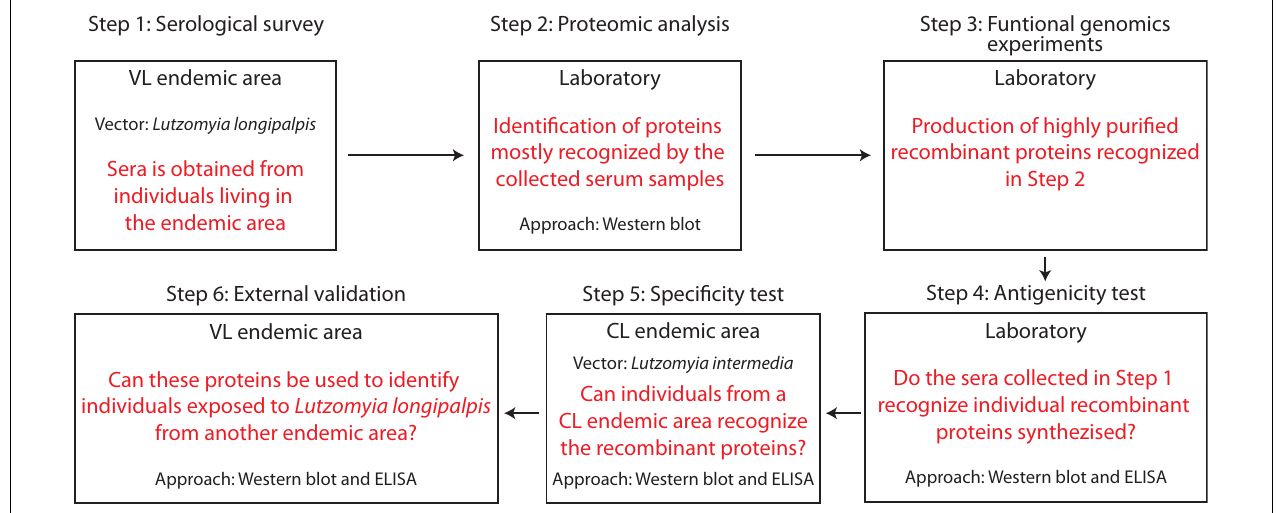
FIGURE 2 | Key steps to implement the use of recombinant proteins from sand fly saliva in serological surveys to estimate exposure to bites and risk of Leishmania